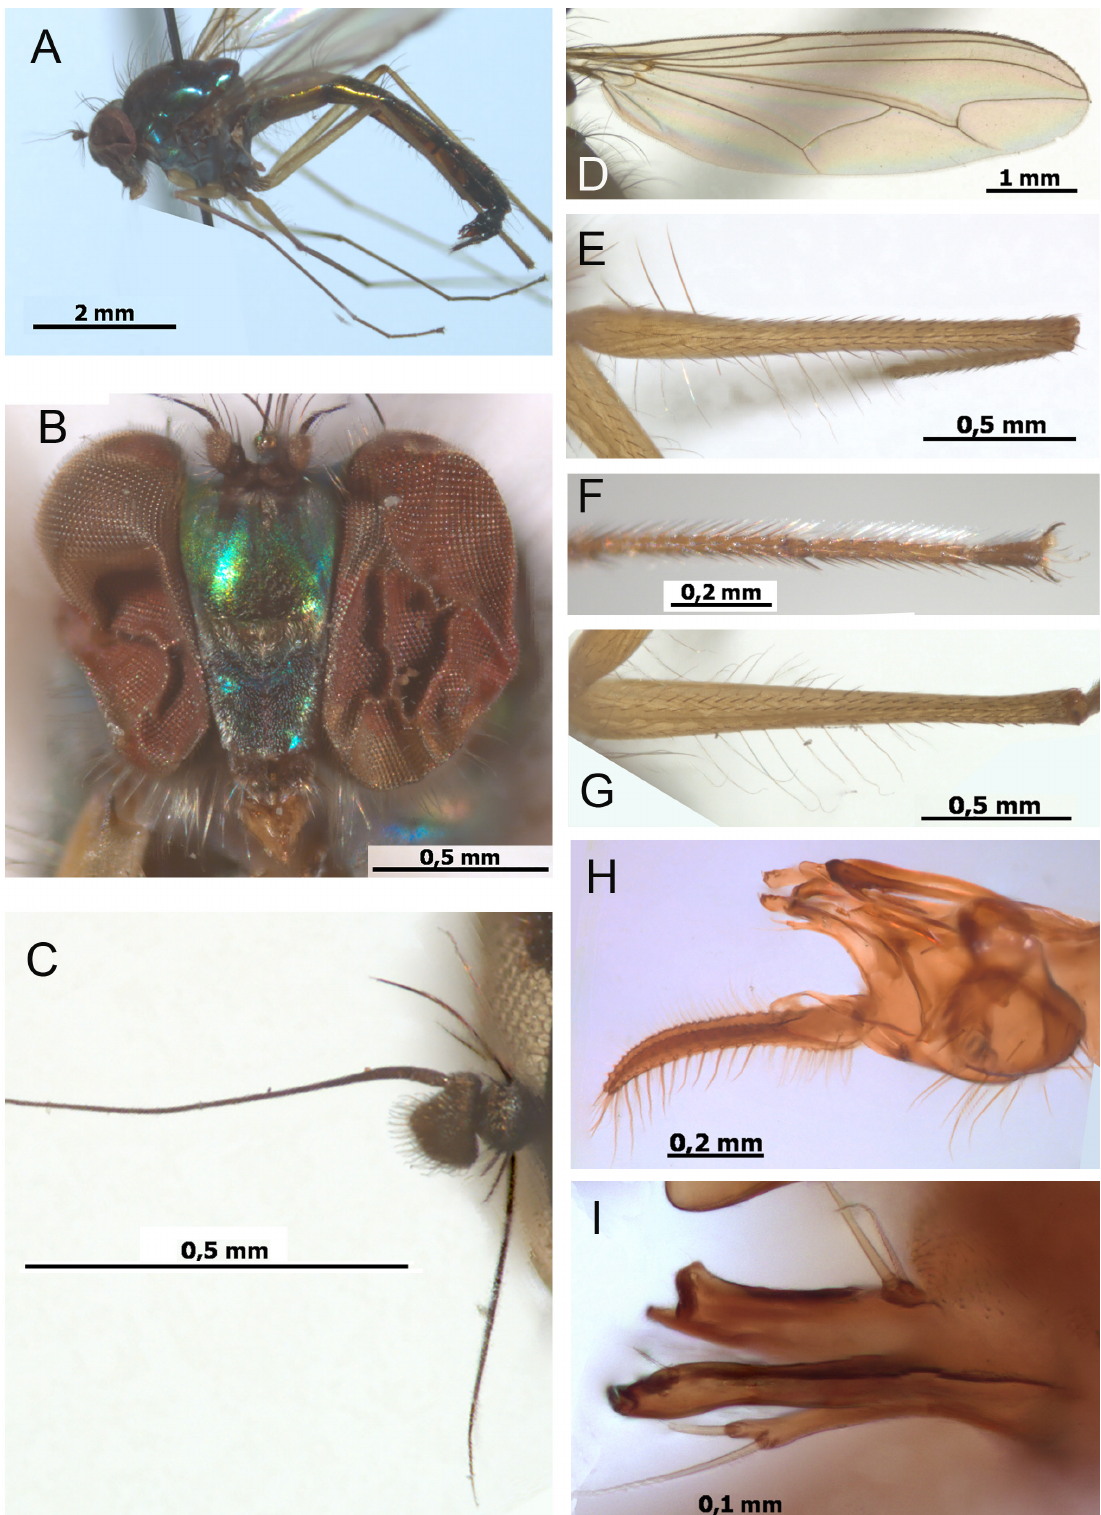
Fig. 6. Amblypsilopus martini sp. nov., holotype, ♂ (A–G: ZMUC); paratype, ♂ (H–I: ZMUC). A . Habitus. B . Head. C . Antenna. D . Wing. E . Fore femur. F . Mid tarsus. G . Mid femur. H . Hypopygium after maceration, left lateral view. I . Surstylus, lateral